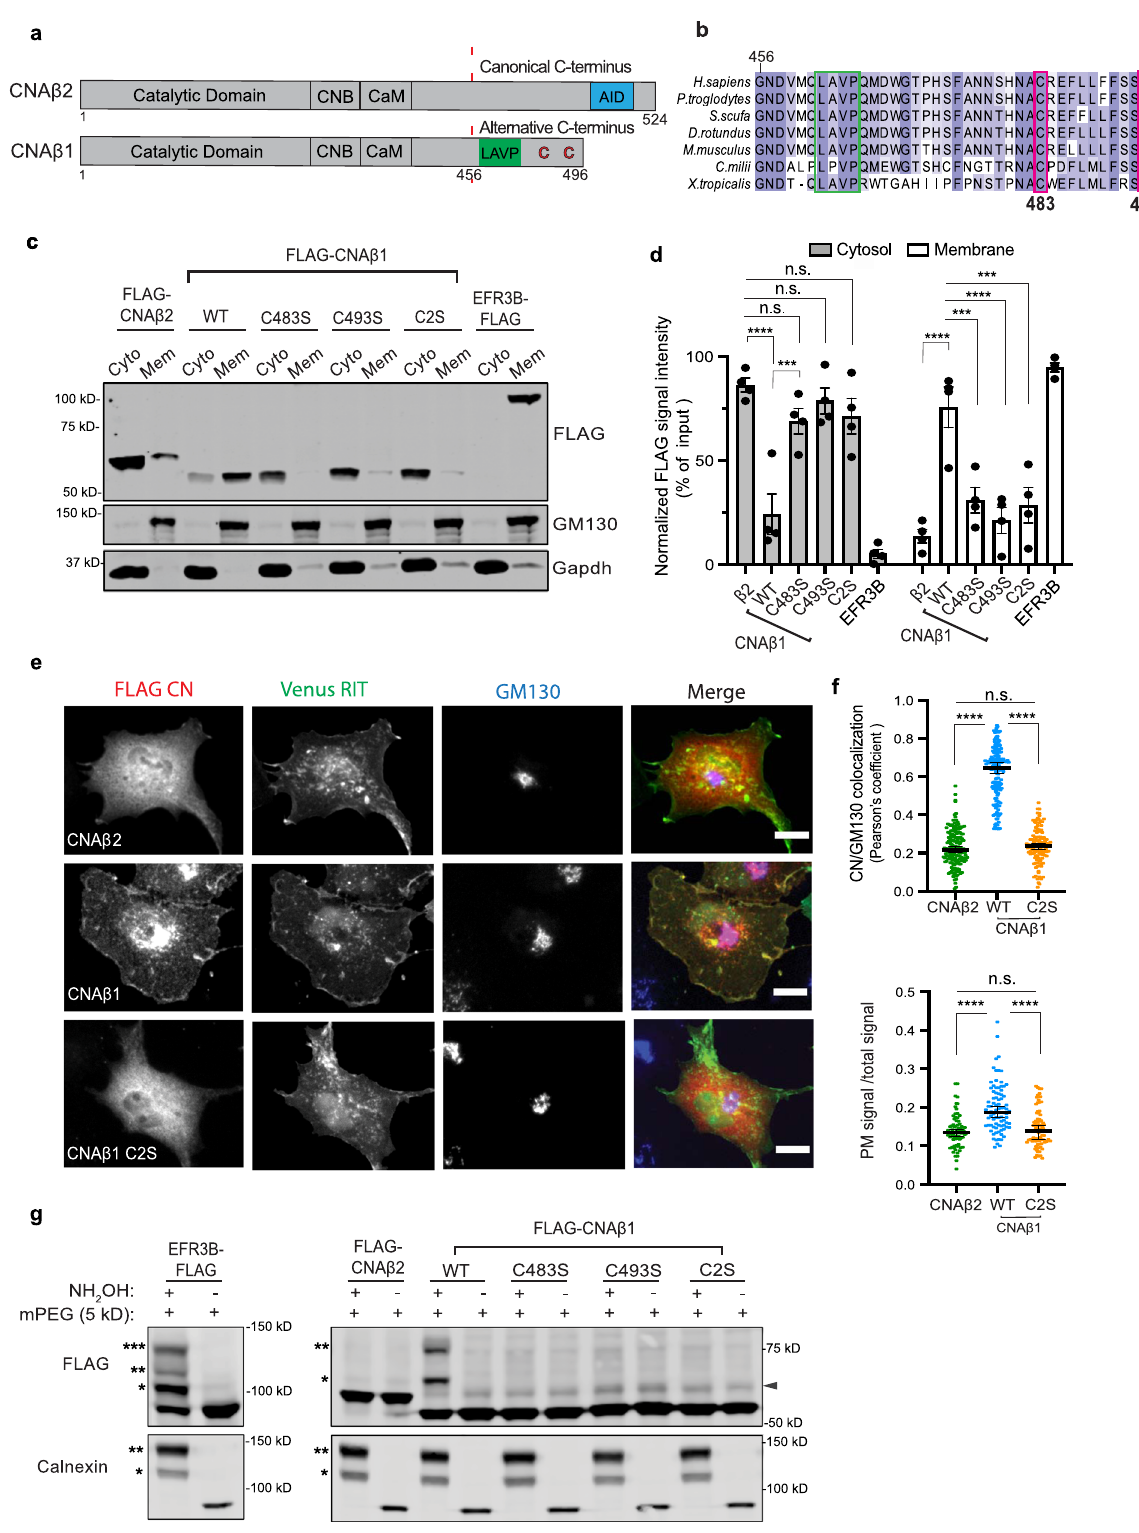
localized to the PM, where it overlapped signi fi cantly with a co-expressed PM marker (Venus-RIT) 30 , the Golgi apparatus, where it co-localized with GM130, and to intracellular vesi- cles. By contrast, CNA β 2 was predominantly cytosolic with minimal co-localization with either membrane marker (Fig. 1e, f). Similar distributions were observed in HeLa cells (Supplementary Fig.